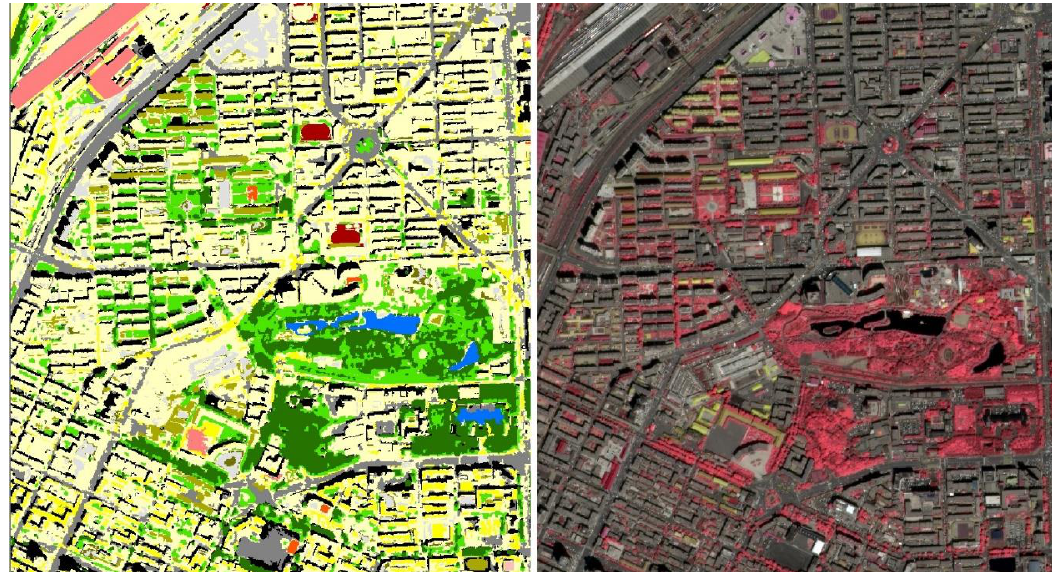
Figure 10. Part of the zoomed view of the LULC layer 3 map (left) and the corresponding GF-2 standard false color composition image (right) in the central urban region of Changchun City.